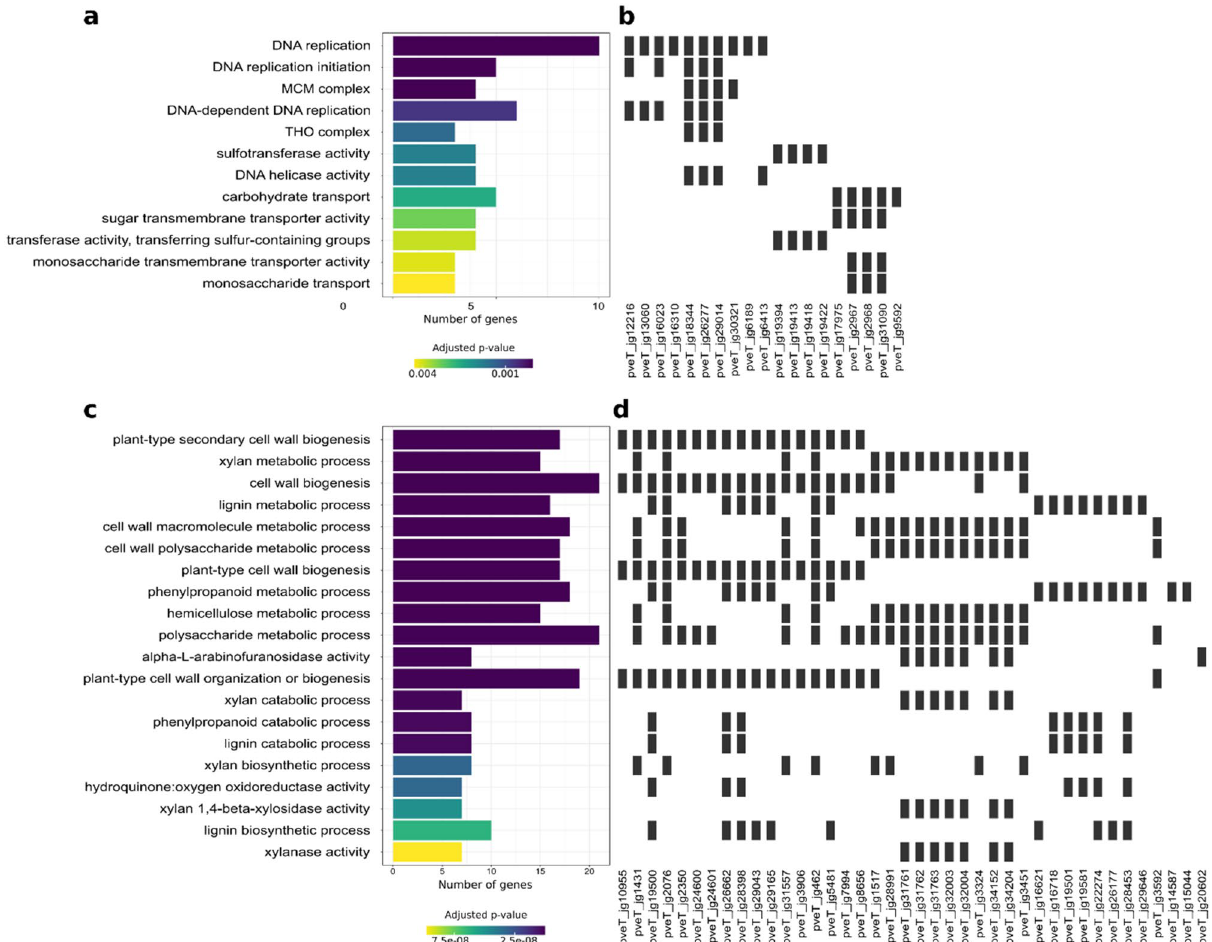
Figure 4. Differential expression analysis in Primula . ( a ) Bar-plot showing the enriched GO terms among down-regulated DEGs in the P. veris style, ordered bottom-up by increasing adjusted p values. The bar length is proportional to the number of genes belonging to each GO category (x-axis). ( b ) Heat-plot showing which genes (x-axis) belong to which GO category. ( c ), ( d ) Same as a and b, but for the 20 most significantly enriched GO terms among up-regulated DEGs in the P. vulgaris flower (full list in Suppl. Table